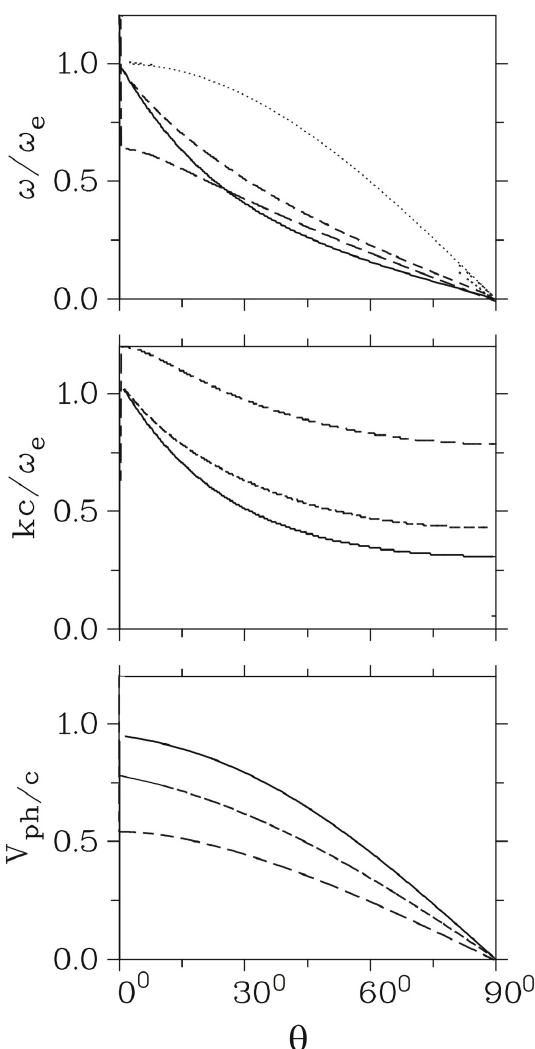
Fig. 3. Frequency, wave number and (maximum) phase velocity at the Gendrin point versus the propagation angle θ for three values of G ; G = 10 (solid line), G = 2 . 5 (short-dashed line) and G = 1 . 3 (long-dashed line). The dotted curve in the upper panel represents the frequency dependence according to the resonance cone